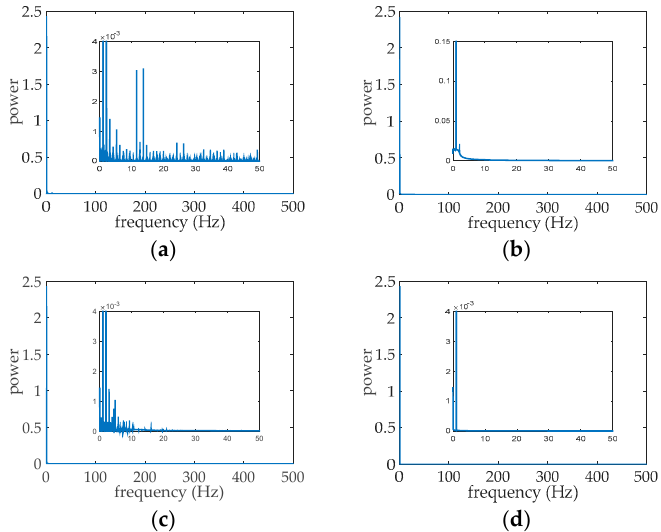
Figure 13. Spectrums of y s in experiment ( a ) before filter, ( b ) after the Butterworth filter; ( c ) after the DWT based filter and ( d ) after the designed filter.